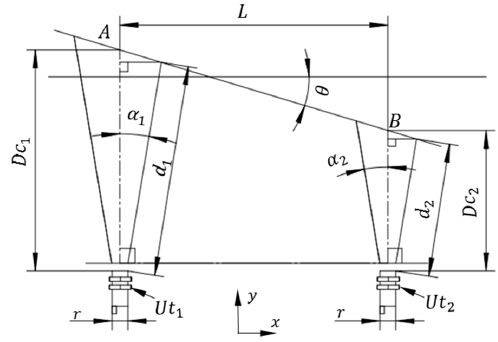
Figure 1. The divergence angle and the incidence angle.